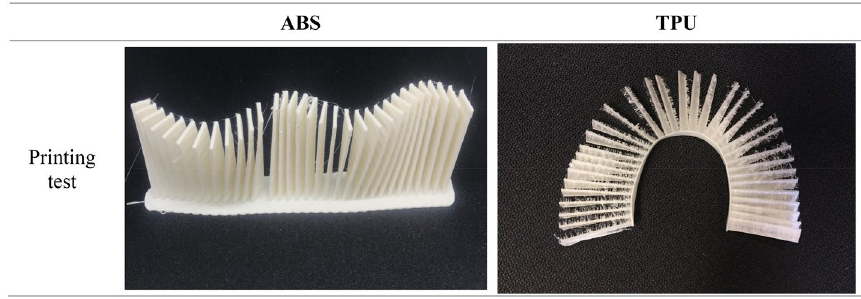
Table 3 Printing material tests for ‘Motif